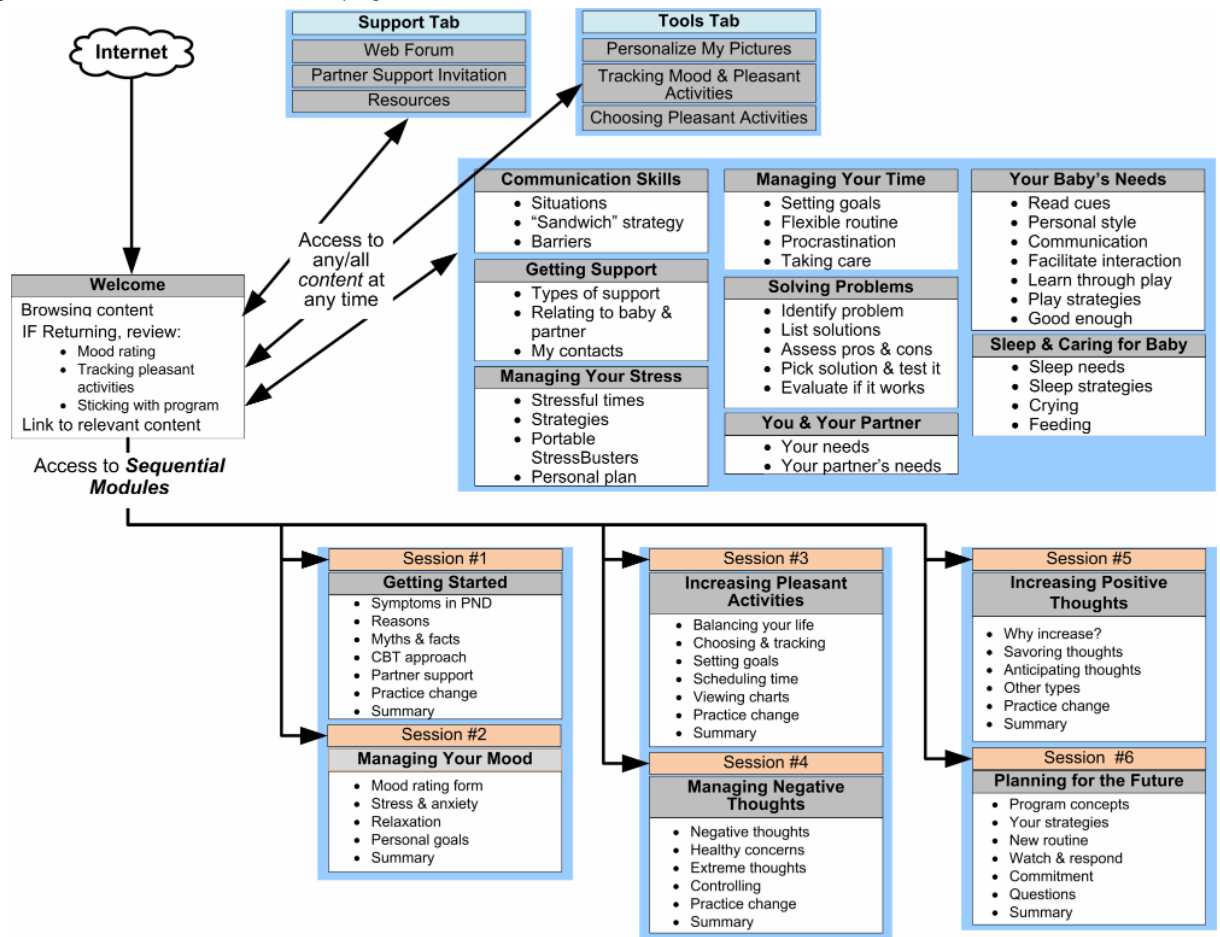
Figure 4. Structure of MomMoodBooster